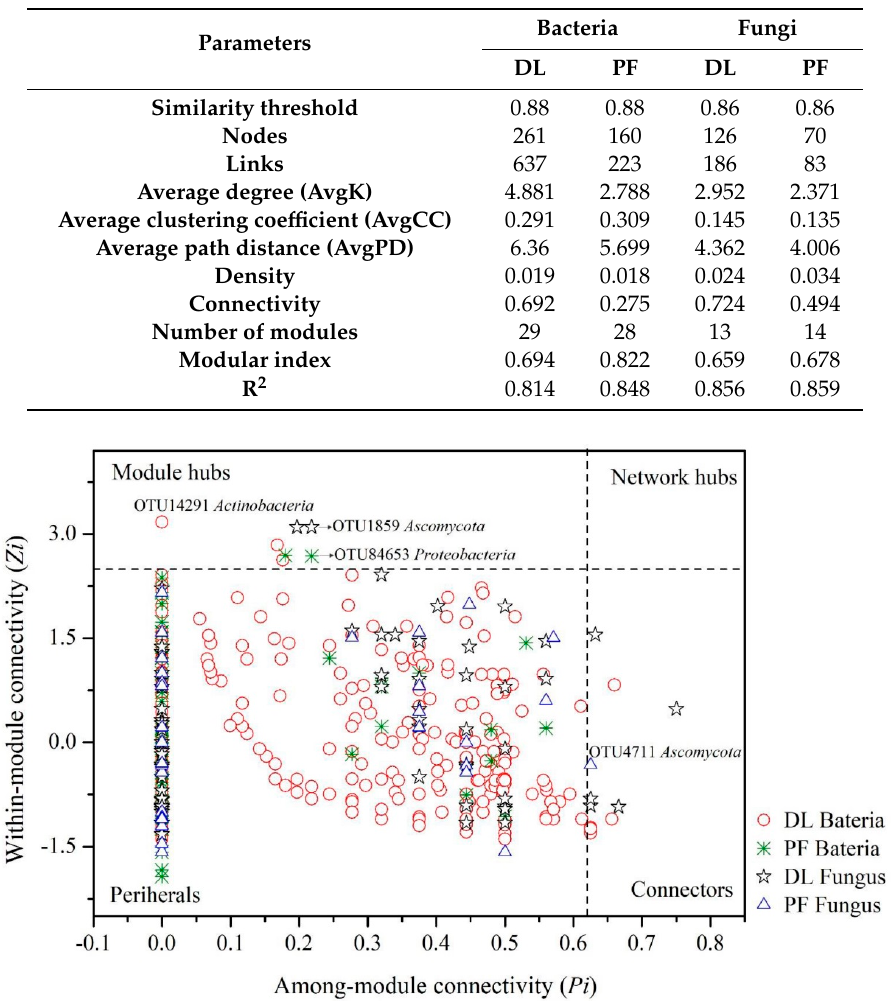
Table 1. Comparison of the topological properties of molecular ecological networks in DL and PF.